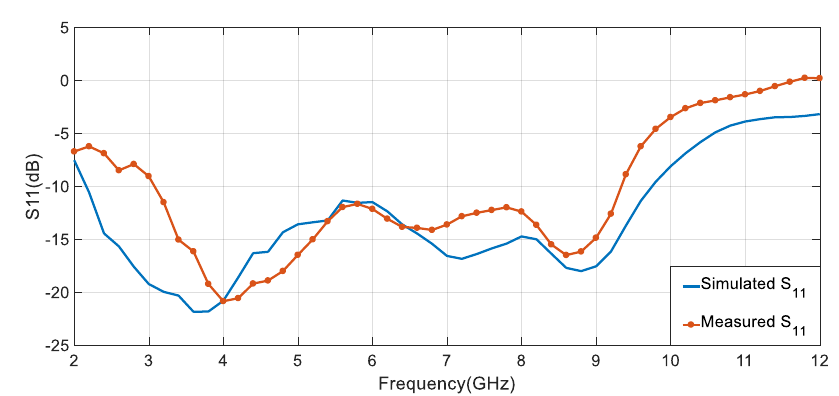
Figure 37. Inner ring rotation.